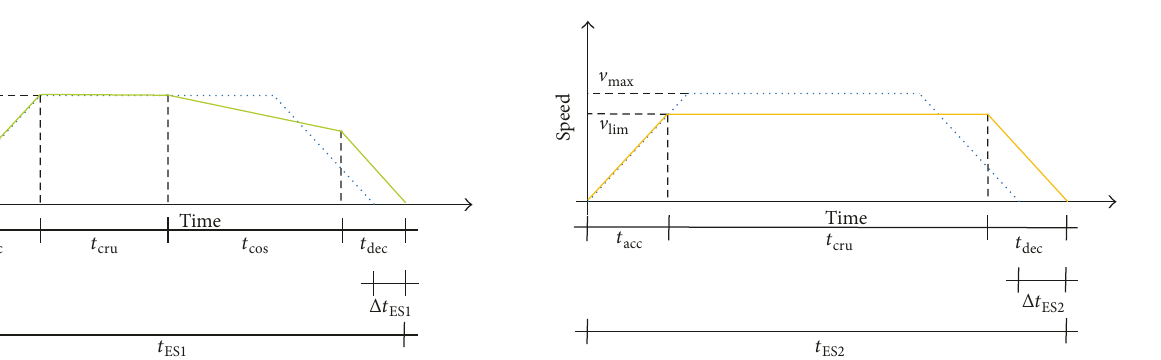
Figure 2: Speed profile in the case of Energy-Saving (ES) strategy 1. Figure 3: Speed profile in the case of Energy-Saving (ES) strategy